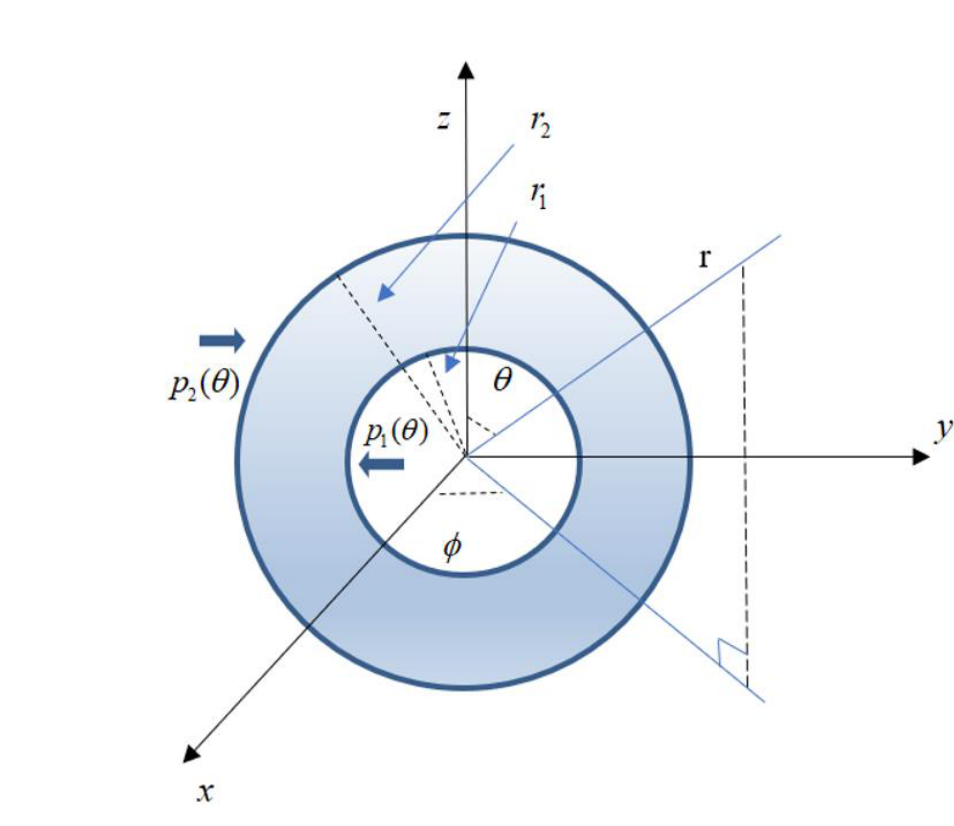
Figure 1. FGM Thick sphere with spherical